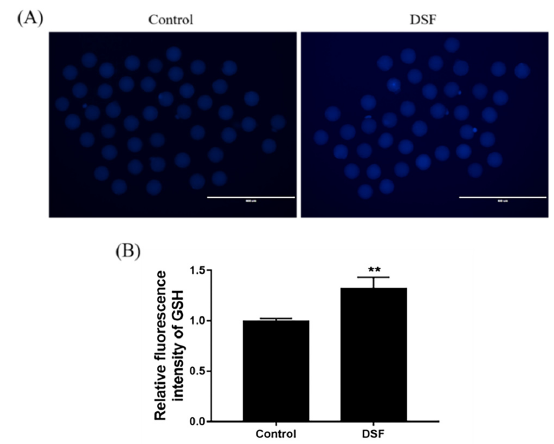
Figure 7. Effect of DSF on GSH level in mouse oocytes. ( A ) Representative images of GSH staining in the control and DSF groups; ( B ) relative fluorescence intensity of GSH in the control and DSF groups. ** p < 0.01; scale bar = 400 µ m. Each test evaluated at least 30 MII oocytes in each group, and